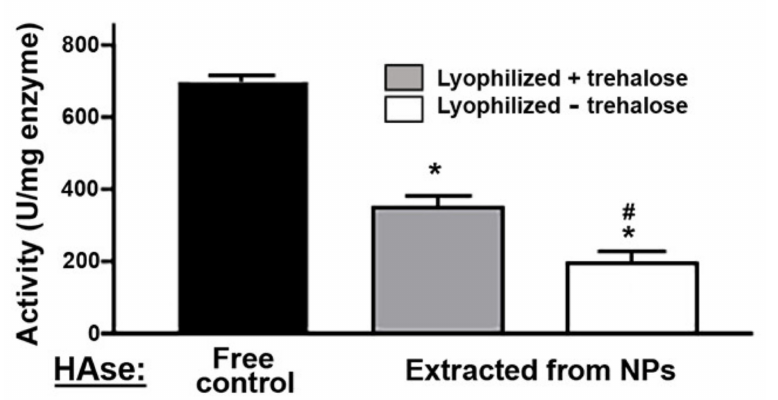
Figure 1. Enzyme activity of hyaluronidase (HAse) encapsulated in poly(lactide-co-glycolide) (PLGA) nanoparticles (NPs). HAse encapsulated in Lactel II–F68 PLGA NPs was extracted from NPs after lyophilization in the presence vs. absence of 7.5% trehalose. Activity was assessed by incubation for 10 min at 37 ◦ C and pH 4.2 with a solution containing 0.4 mg/mL hyaluronic acid (HA), after which the HA content left undegraded was measured by absorbance at 540 nm. The activity of free, non-encapsulated HAse is shown as a control. Data are the mean ± standard error of the mean (SEM) ( n ≥ 3). * Compared to free HAse control; # Compared to trehalose (Student’s t -test; p <